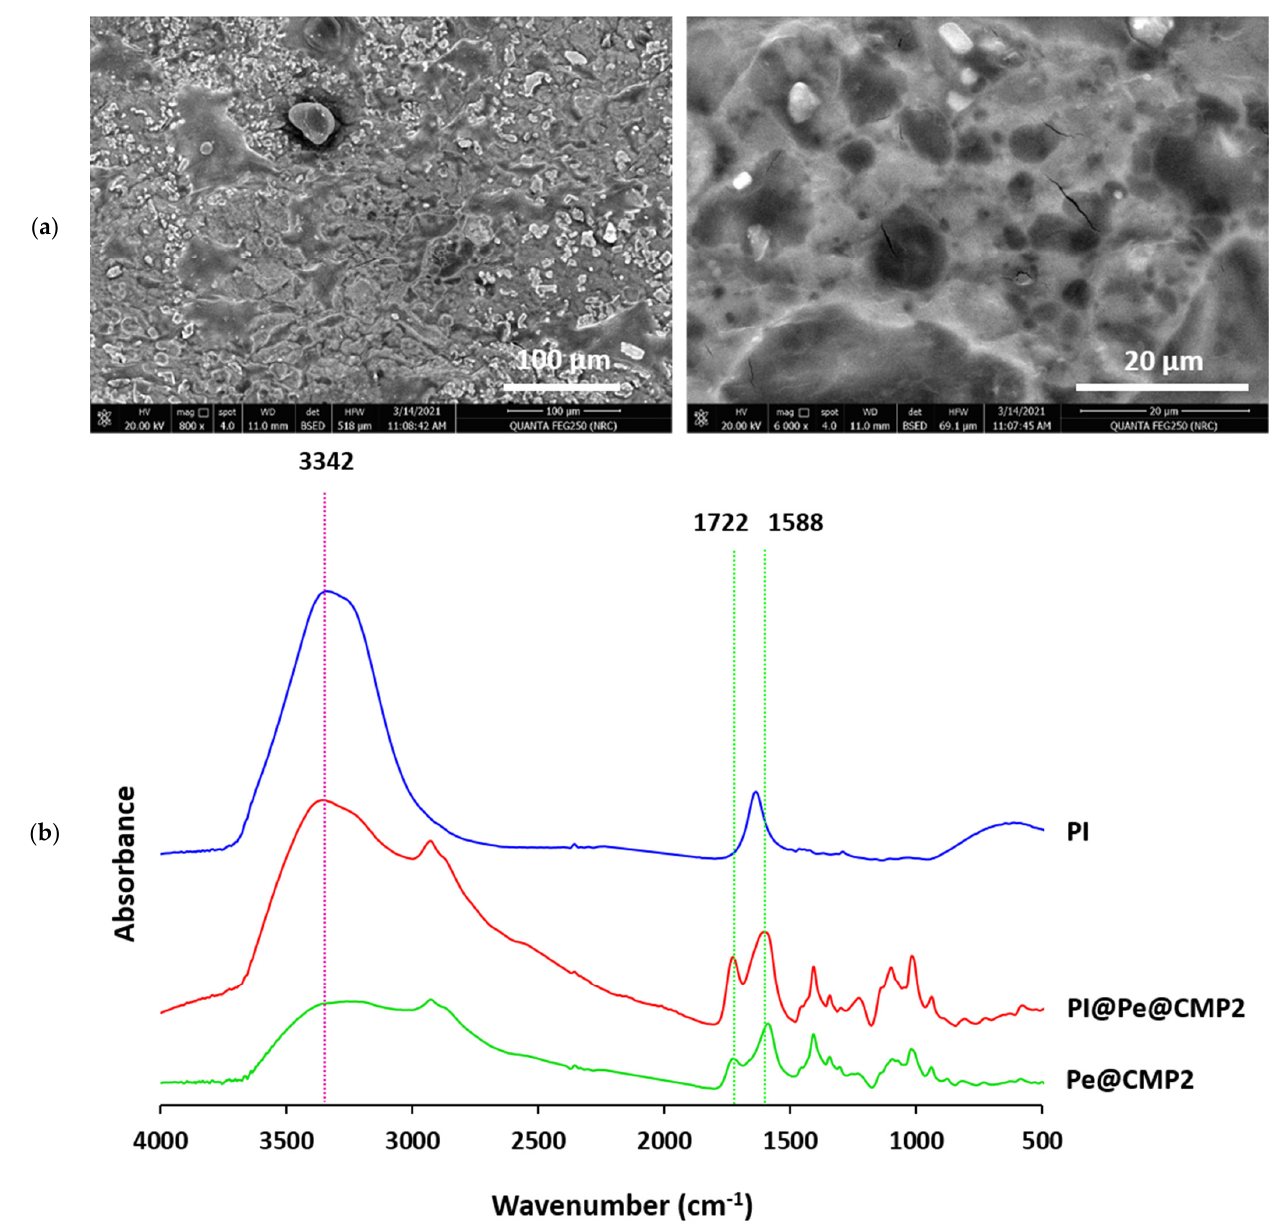
Figure 6. ( a ) Micrographs and ( b ) FTIR for the